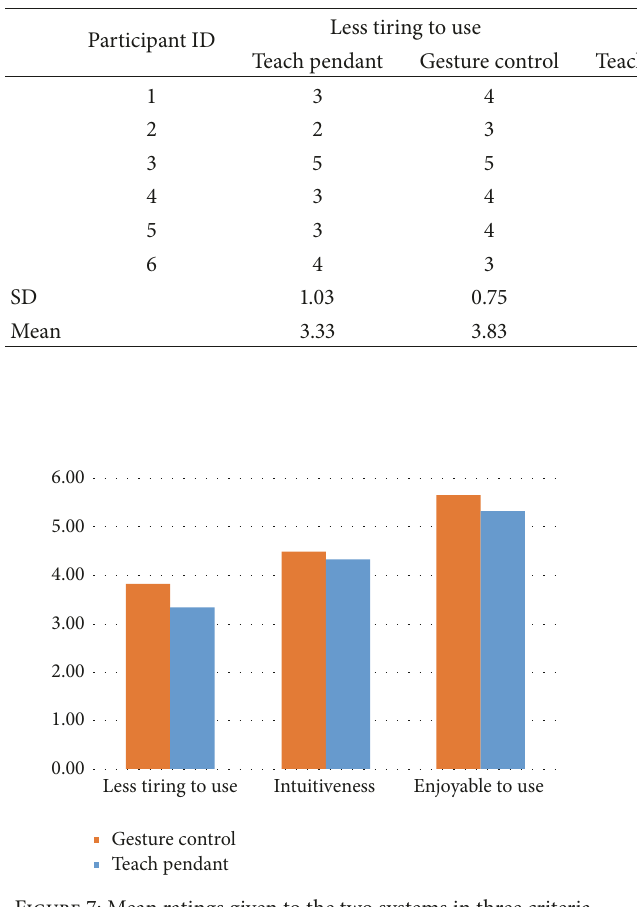
Figure 7: Mean ratings given to the two systems in three